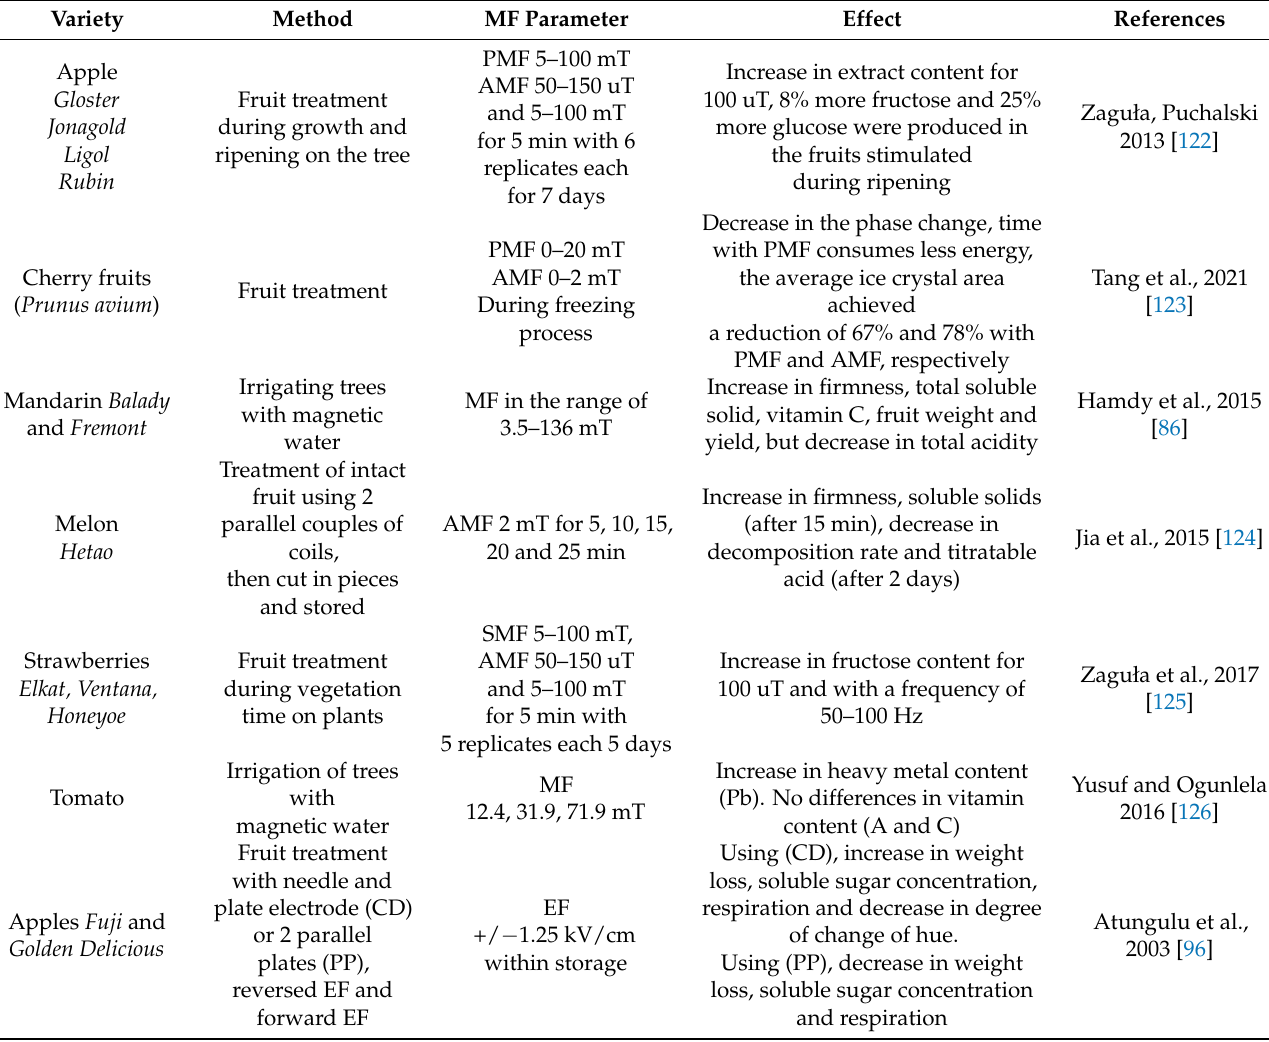
Table 3. Summary of the total effect of magnetic fields and electrical fields on fruit